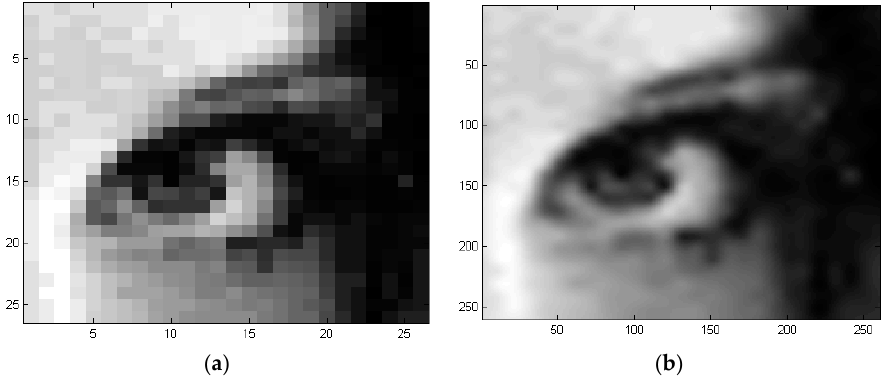
Figure 11. Reconstruction from few control points by using global TPS algorithm: ( a ) Low resolution image containing 26 × 26 Pixels 2 ; ( b ) Reconstructed at a higher resolution of 260 × 260 Pixels 2 .